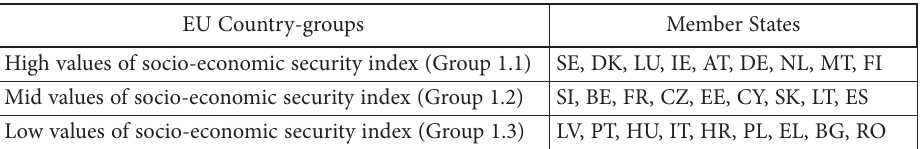
Table 3. EU country groups (source: own processing using Microsoft Office Excel 2016 and the data presented above) EU Country-groups Member States High values of socio-economic security index (Group 1.1) SE, DK, LU, IE, AT, DE, NL, MT, FI Mid values of socio-economic security index (Group 1.2) SI, BE, FR, CZ, EE, CY, SK, LT, ES Low values of socio-economic security index (Group